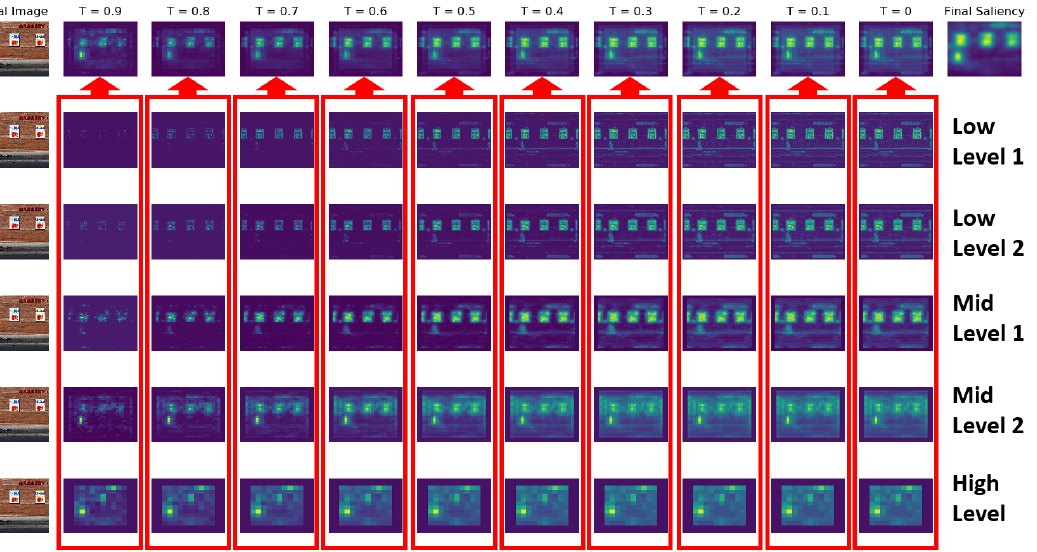
Figure 4. Detailed maps of different levels (from Low Level 1 to High Level) and different thresholds on feature rarity (from 0.9 to no threshold) within the VGG16